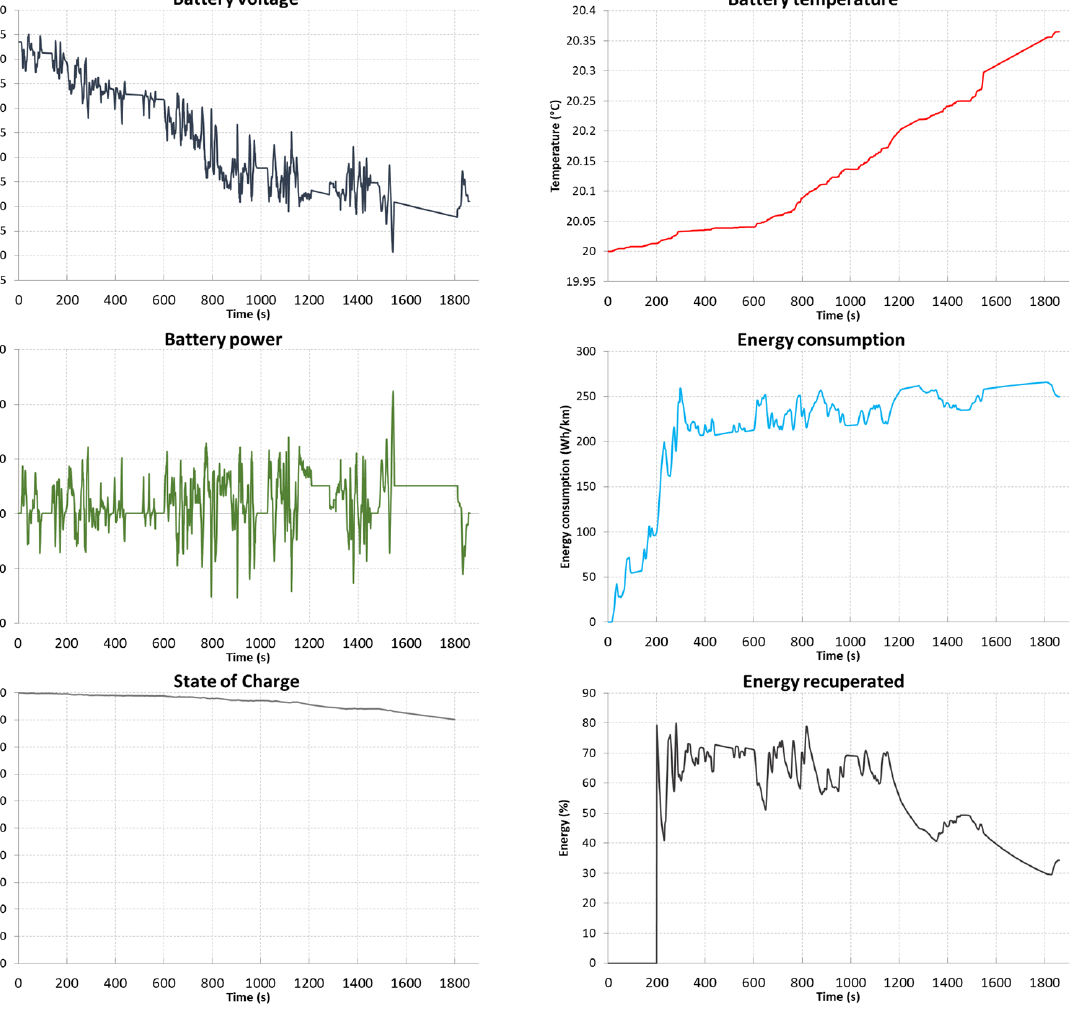
Figure 12. WLTP-90 results of simulation tests for the 4 × 4 drive system with Type 1 energy storage.